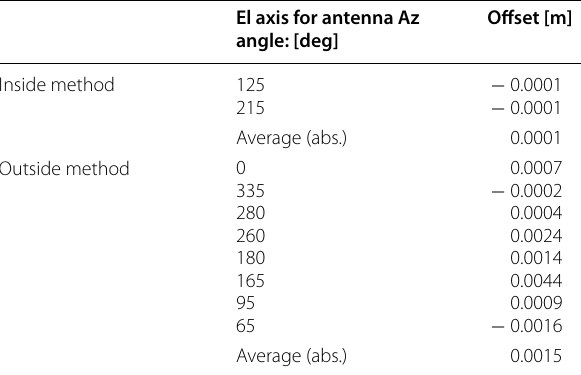
Table 5 Offsets between Az and El axes estimated by the inside method and outside method El axis for antenna Az angle: